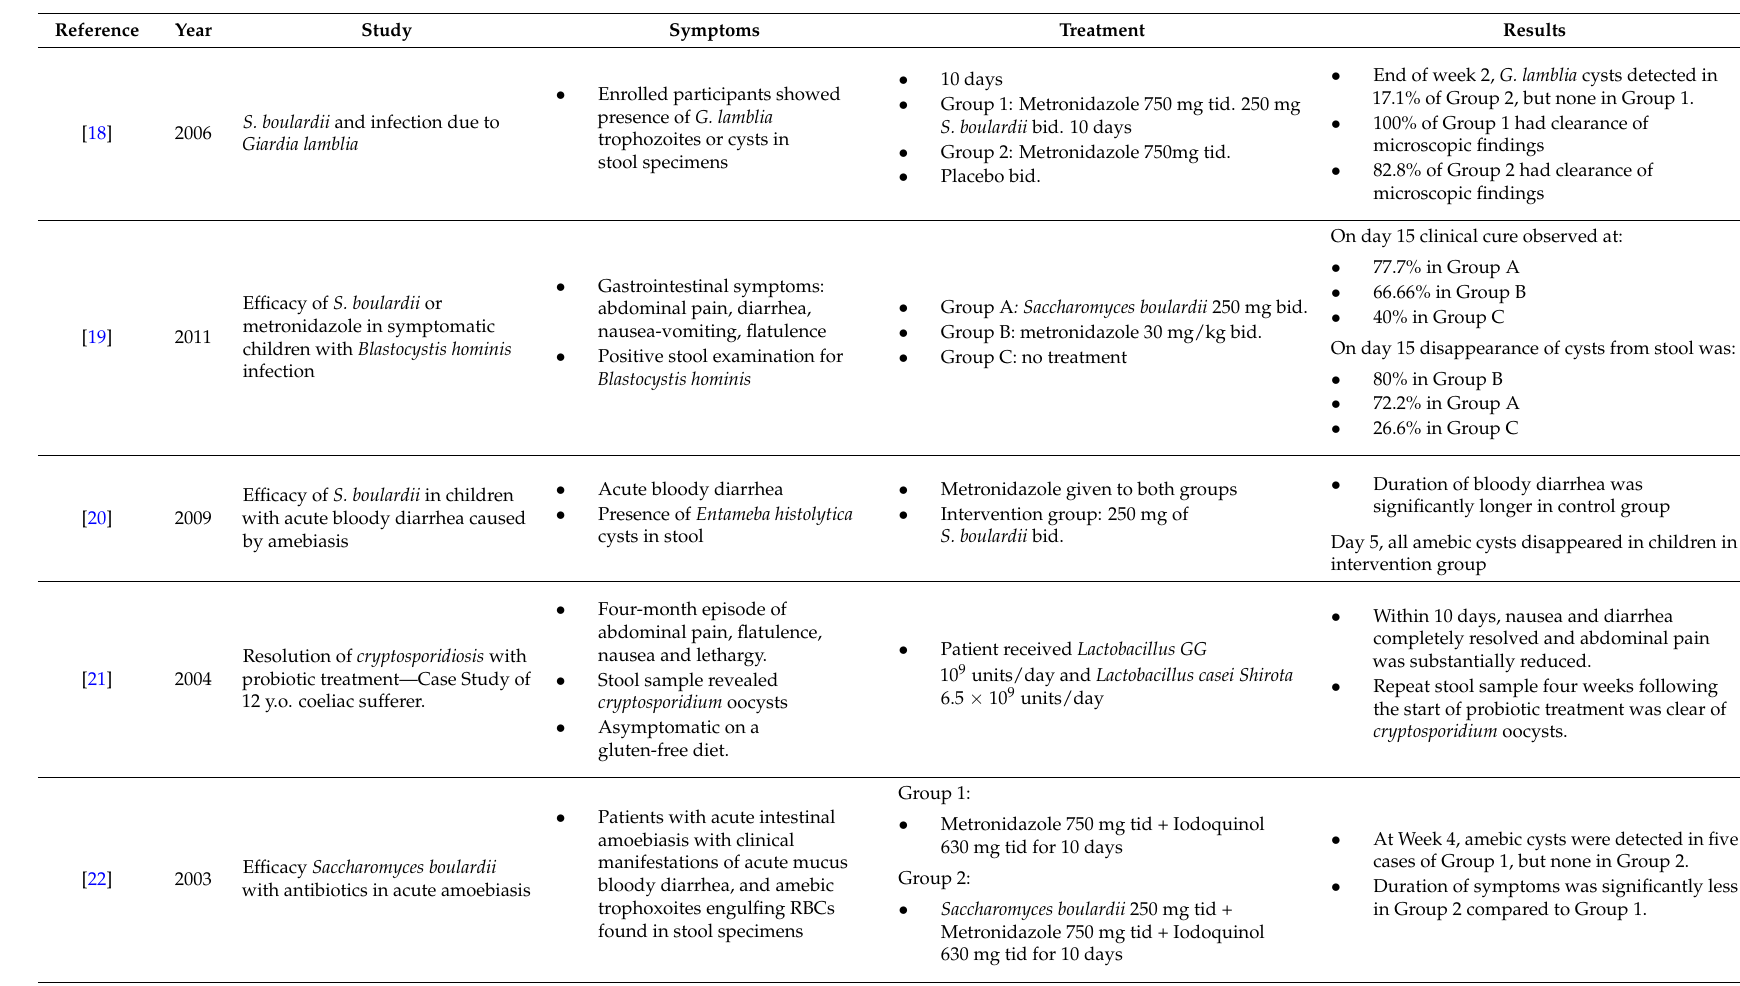
Table 2. Clinical studies on the administration of probiotics or pharmaceuticals to eradicate protist